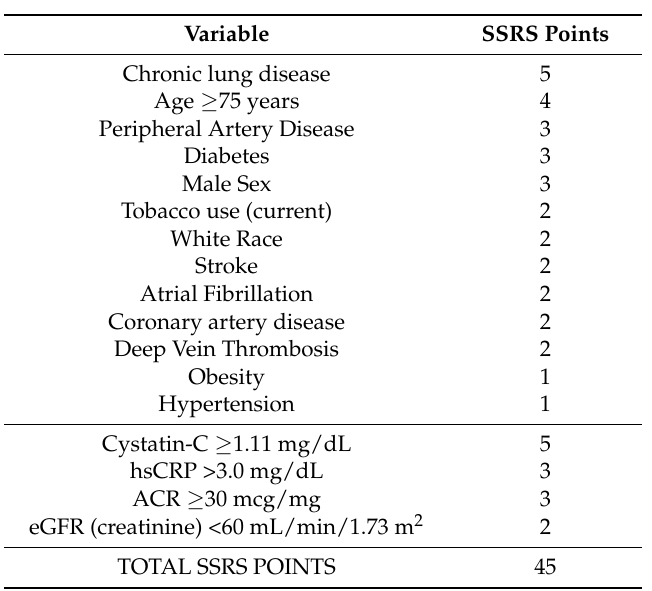
Table 1. The REGARDS Severe Sepsis Risk Score